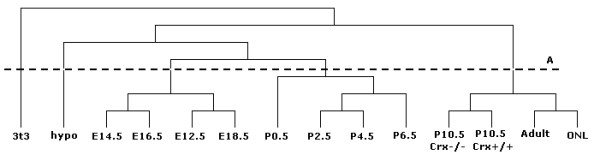
A hierarchical tree for 14 SAGE libraries based on analysis of 1118 tags. The hierarchical tree was generated based on 1118 tags highly expressed in the ONL library using Pearson correlation-based hierarchical clustering method. Five clusters are obtained when cutting the dendrogram at level A.